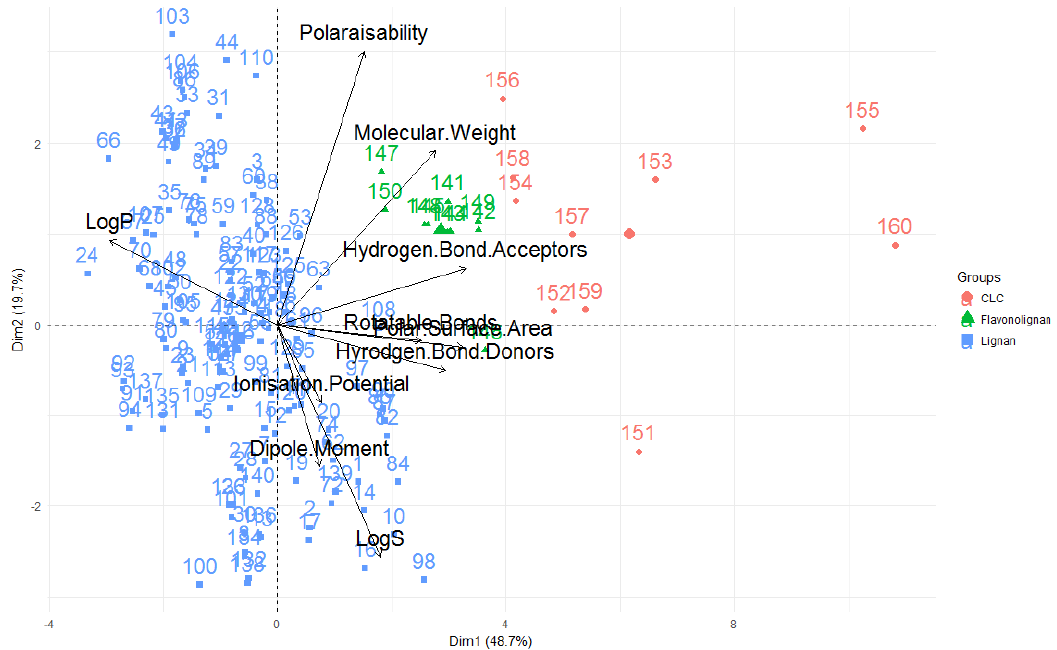
Figure 9. Biplot representing the PCA analysis on the studied compounds and molecular descriptors. The arrows represent molecular descriptors and the direction in which they hold influence. Each point represents a molecule in this study (blue = classical lignans and neolignans, green = flavonolignans, red = CLCs).